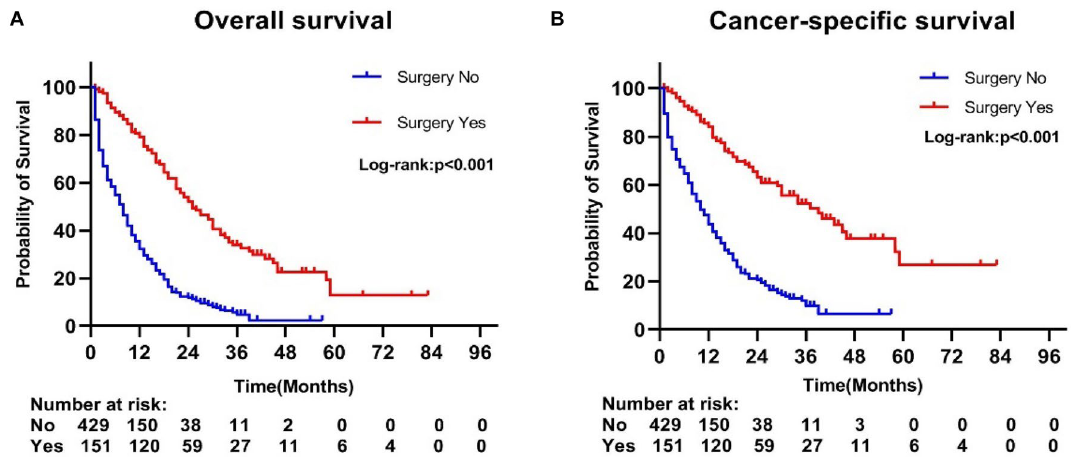
Figure 2. Kaplan–Meier curves of ( A ) overall and ( B ) cancer-specific survival according to whether patients underwent primary tumor surgery in the overall